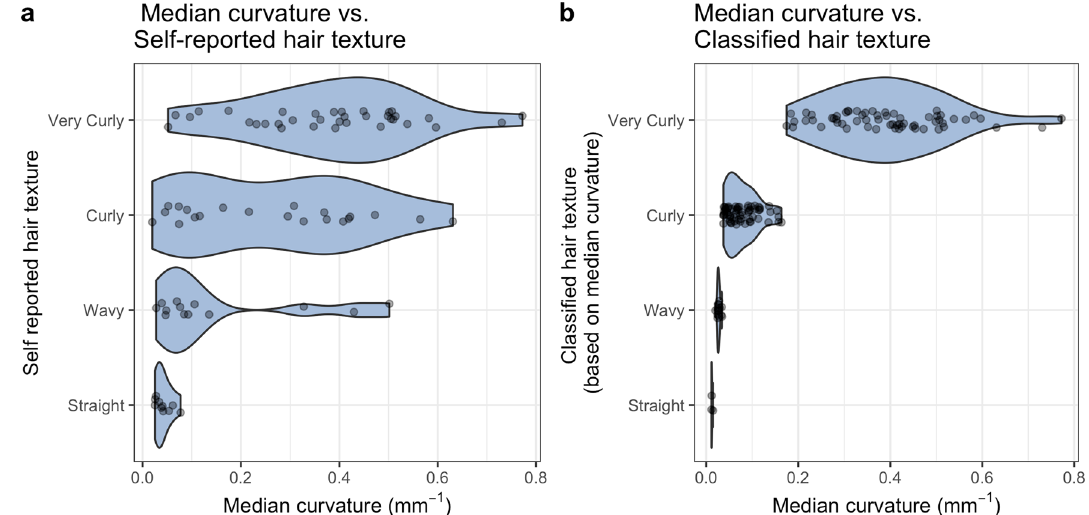
Figure 5. Comparison of quantitative and qualitative hair morphology. ( a ) Self-reported hair form shows inconsistency among individuals with regards to the level of curvature encompassed by each category. ( b ) Classifying hair based on objective curvature Loussouarn et al. 2007, obscures the wide range of variation that exists in the “Very Curly”